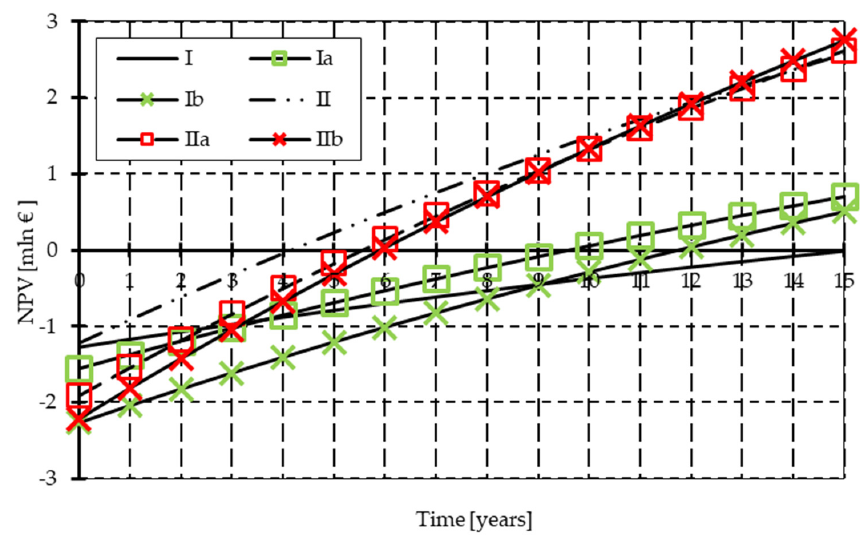
Figure 6. NPV value for analysed variants.